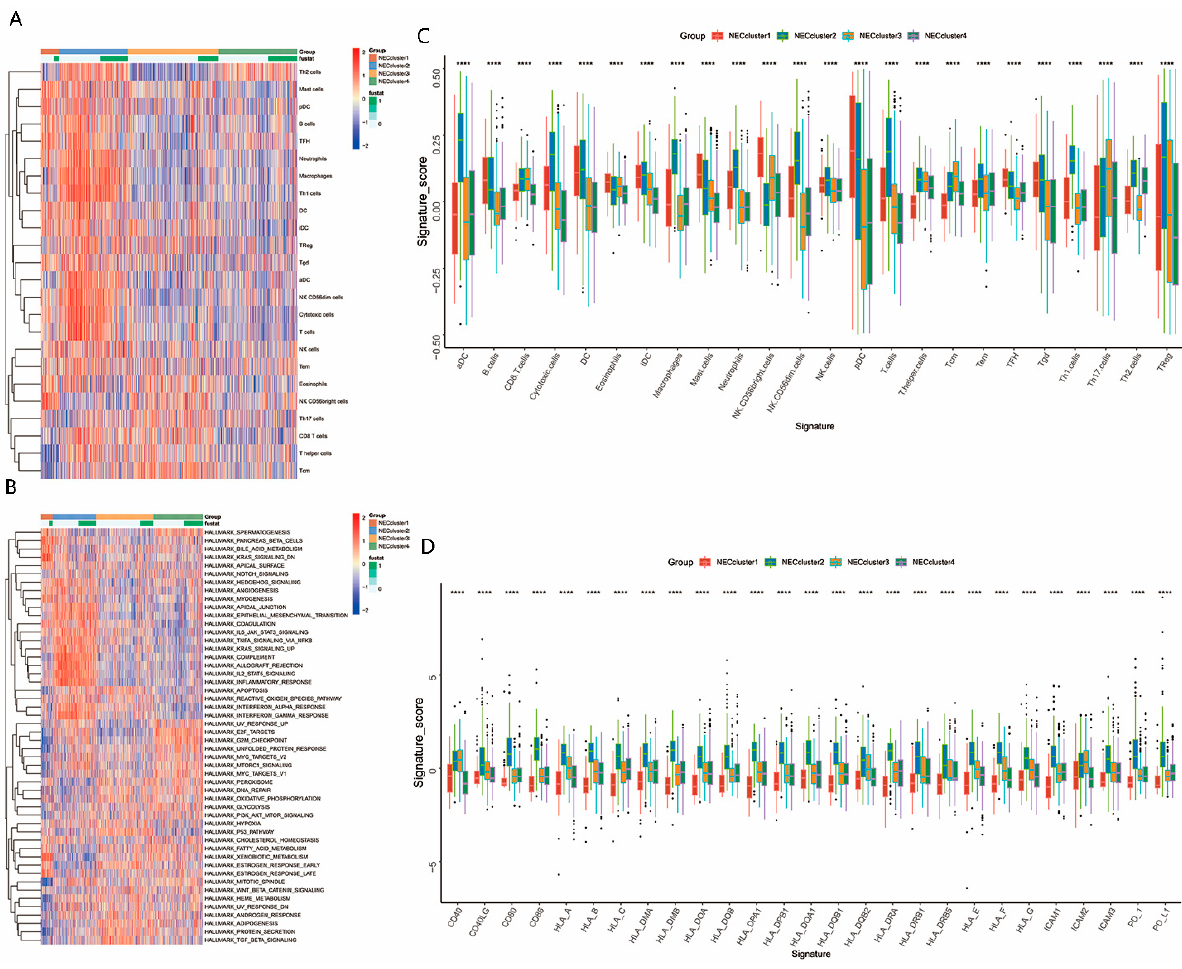
Figure 2. TME immune cell infiltration and biological process characteristics in distinct hypoxia response patterns. ( A ) Hierarchical clustering of TME infiltration immune cells for 403 patients in the meta-BLCA cohort. Rows represent relative amount of each immune cell, and columns represent BLCA samples. Red represents relative upregulation and blue represents relative downregulation of each immune cell. The NEC clusters are shown as patient annotations. ( B ) ssGSEA showed the relative activity of biological pathways in distinct necroptosis-related gene expression patterns in